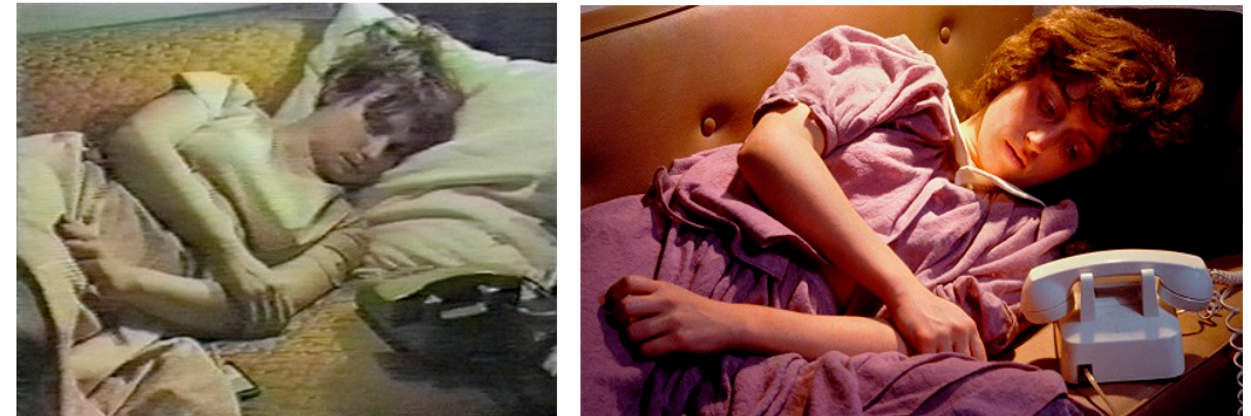
Figure 10. ( Left ) Dušan Mandi ć , Marina Gržini ć , Hysteria’s Production Presents the Reconstruction of the Photographs of Cindy Sherman, 1984, video, color, sound, 3’. ( Right ) Cindy Sherman, Untitled #90, 1981, chromogenic print, 61 × 121.9 cm, Des Moines Art Center.